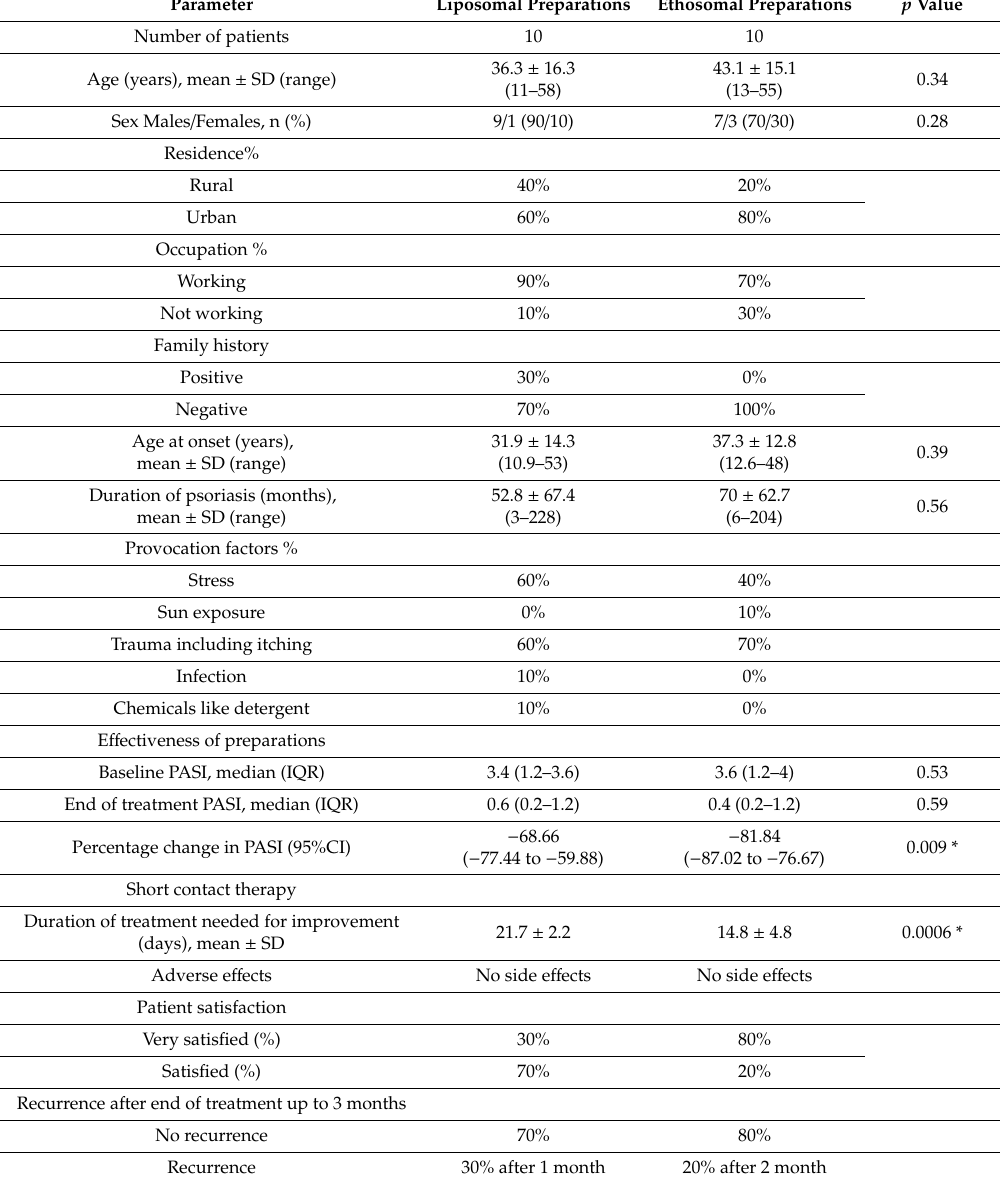
Table 5. Demographic information for the patients participating in the clinical evaluation of anthralin-ethosomal and liposomal